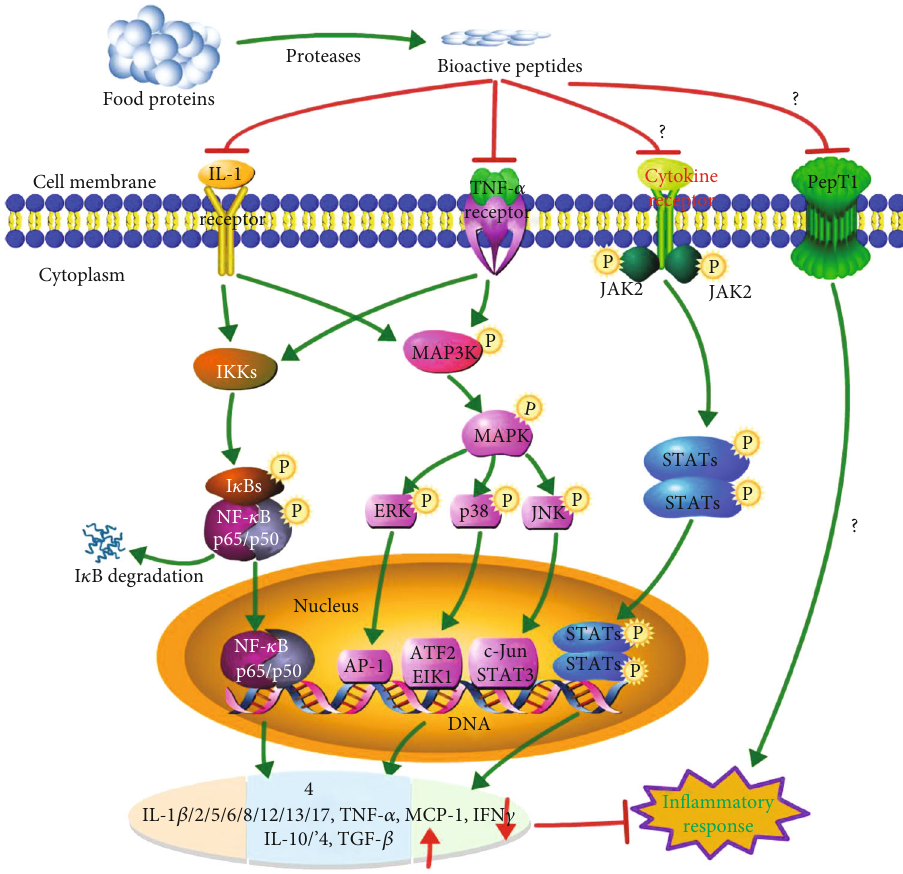
Figure 2: Schematic diagram of possible anti-in fl ammatory mechanism of bioactive peptides derived from food proteins. The anti- in fl ammatory activity may be via the following four pathways: NF- κ B, MAPK, JAK-STAT, and PepT1. IL-1: interleukin-1; LPS: lipopolysaccharides; MAPK: mitogen-activated protein kinase; MAP3K: MAPK kinase kinase; NF- κ B: nuclear factor-kappa B; TGF- β : transforming growth factor β ; TNF- α : tumor necrosis factor α ; JAK-STAT: Janus kinase-signal transducer and activator of transcription. This diagram was drawn using an online pathway builder tool (http://www.proteinlounge.com). Adapted from previous reports [2, 7, 10, 20, 37 –